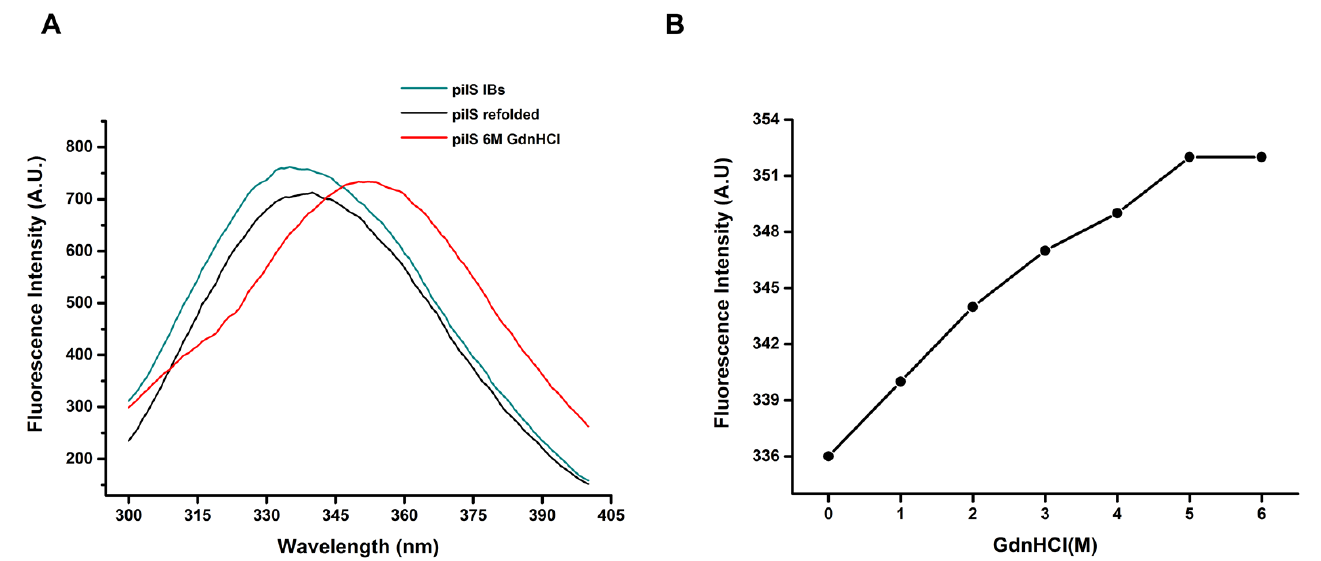
Figure 7. Fluorescence analyses of recombinant rPilS. ( A ) Tryptophan fluorescence emission spectra of rPilS; IBs, rPilS refolded and pilS denaturated with 6 M GdnHCl. ( B ) rPilS λ maximum shift induced by rising GdnHCl concentrations.